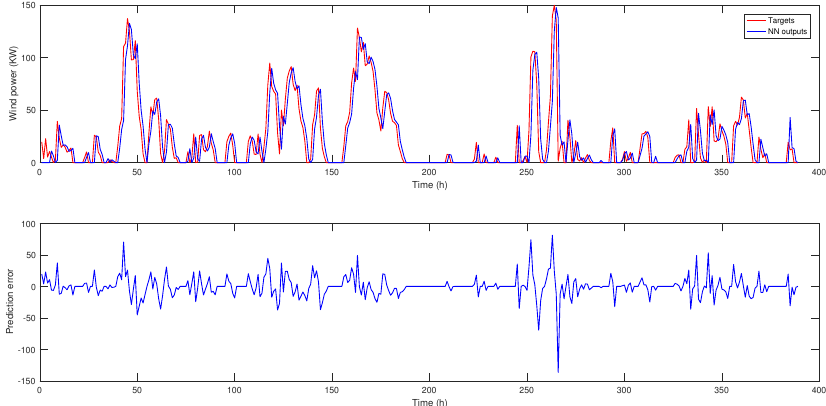
Figure 5. Actual and short-term forecast total system wind power